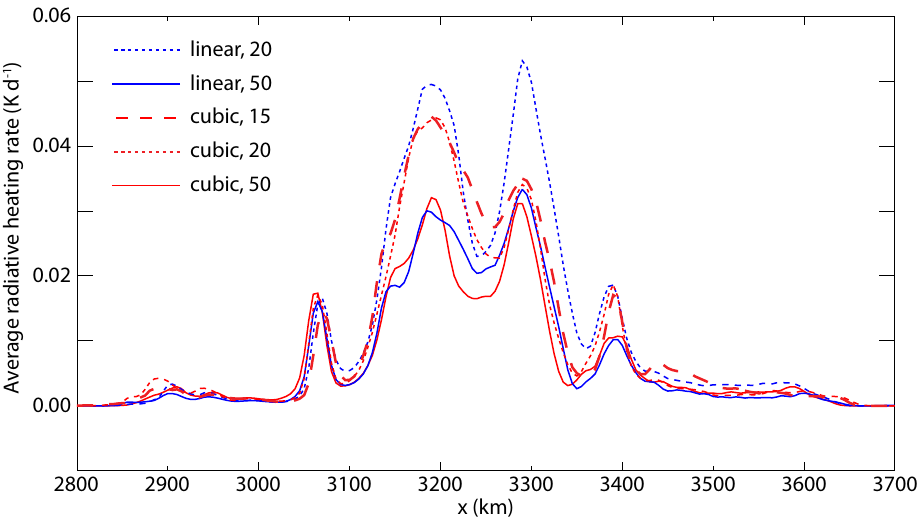
Fig. 7. Radiative heating, averaged over the same range of z as in Fig. 5, obtained by using the linear scheme at 20 and 50 bins and the cubic scheme at 15, 20 and 50 bins.